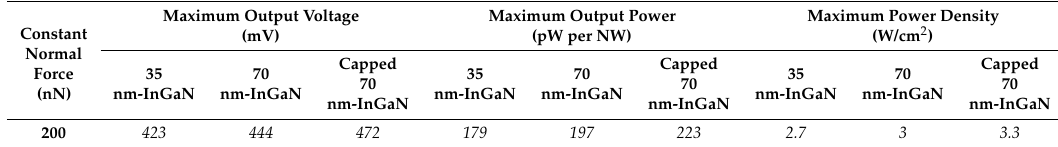
Table 3. Maximum output voltages, output powers and power densities of 35 nm-thick InGaN/GaN; 70 nm-thick InGaN/GaN; and GaN capped 70 nm-thick InGaN/GaN NWs at a constant normal force of 200